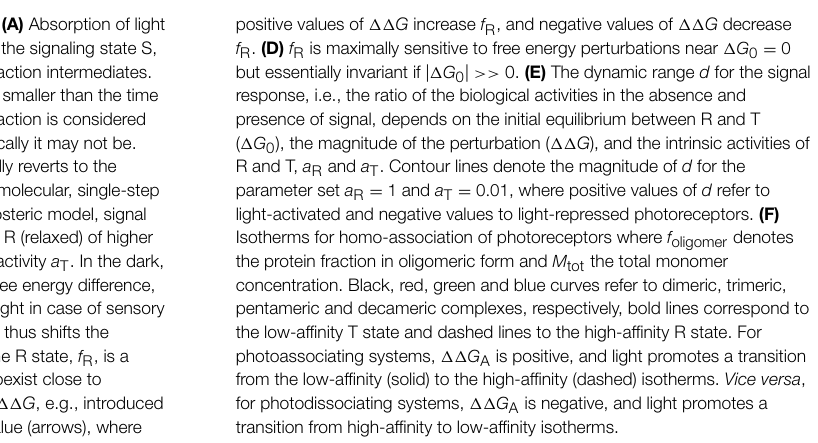
FIGURE 2 | Thermodynamics of photoreceptors. (A) Absorption of light drives the transition from the dark-adapted state D to the signaling state S, which depending upon photoreceptor, may involve reaction intermediates. As the life time of these intermediates is usually much smaller than the time scale of optogenetic applications, operationally the reaction is considered unimolecular and single-step even though mechanistically it may not be. Once in the signaling state, the photoreceptor thermally reverts to the dark-adapted state which again is assumed to be unimolecular, single-step with rate constant k 1 . (B) In the framework of an allosteric model, signal − receptors exist in dynamic equilibrium between states R (relaxed) of higher biological activity a R and T (tense) of lower biological activity a T . In the dark, the equilibrium between R and T is governed by the free energy difference, 1 G 0 , between these states. Introduction of a signal, light in case of sensory photoreceptors, (de)stabilizes the R and T states, and thus shifts the equilibrium to 1 G S . (C) The fractional population of the R state, f R , is a function of 1 G 0 . Significant populations of R and T coexist close to equilibrium, i.e., 1 G 0 0 . Free energy perturbations 11 G , e.g., introduced = by signal or mutation, shift the equilibrium to a new value (arrows), where